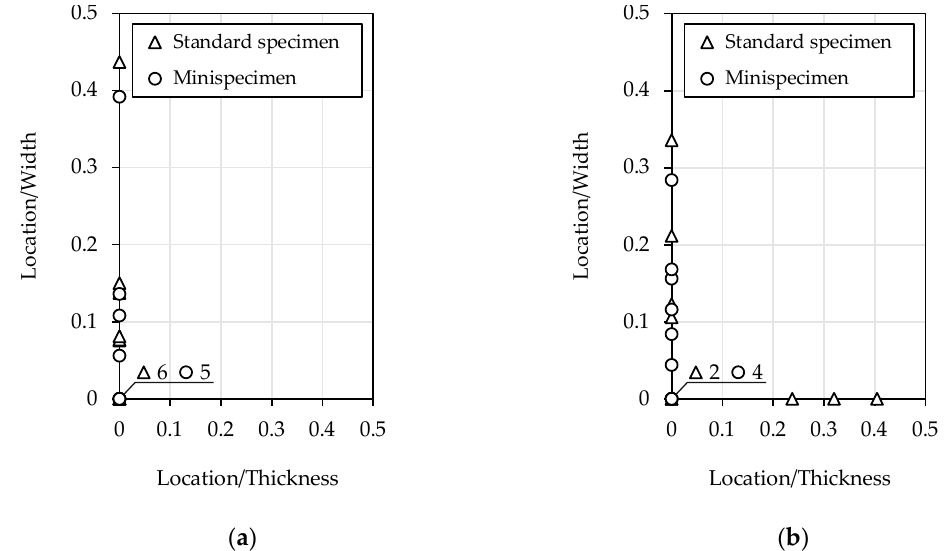
Figure 13. Location of crack origin for: ( a ) S235JR steel; ( b ) 1.4301 steel.